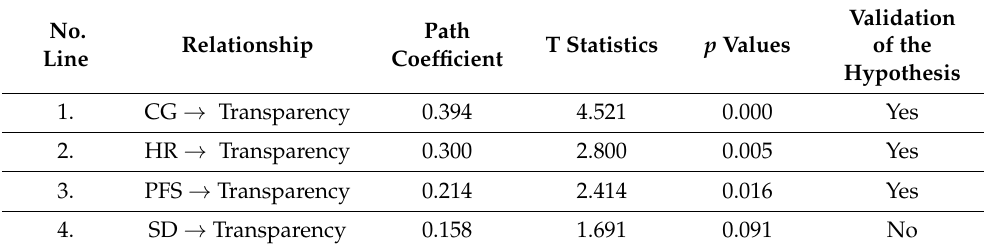
Table 3. Testing the significance of path